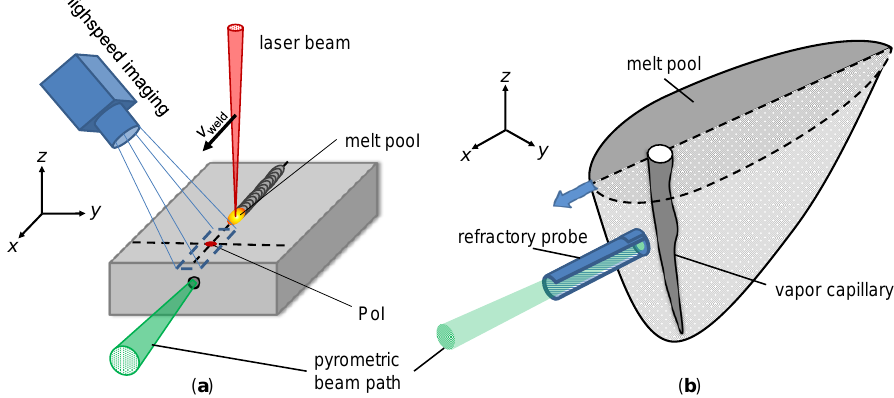
Figure 1. Schematic of the process observation: ( a ) total view of the sample showing pyrometry and high-speed imaging methods during the welding process, and ( b ) close-up on the melt pool probing.